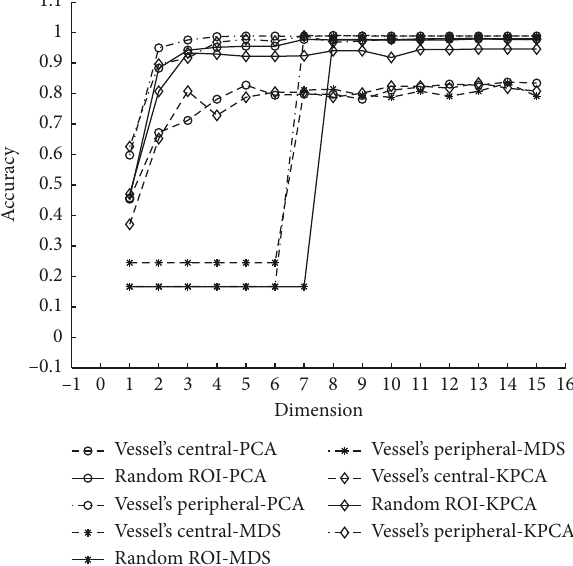
Figure 11: Spectral classification comparisons with SVM